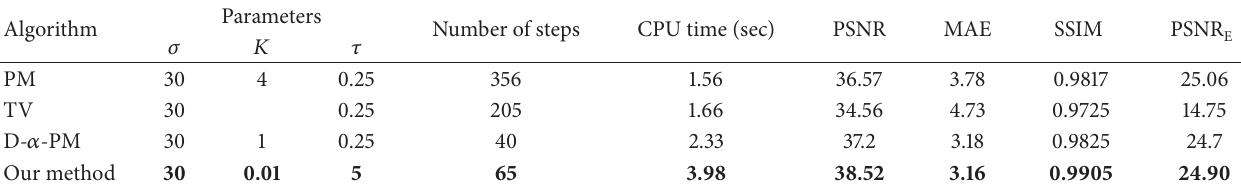
Table 1: Numerical results for synthetic image (300 × 300) experiments.